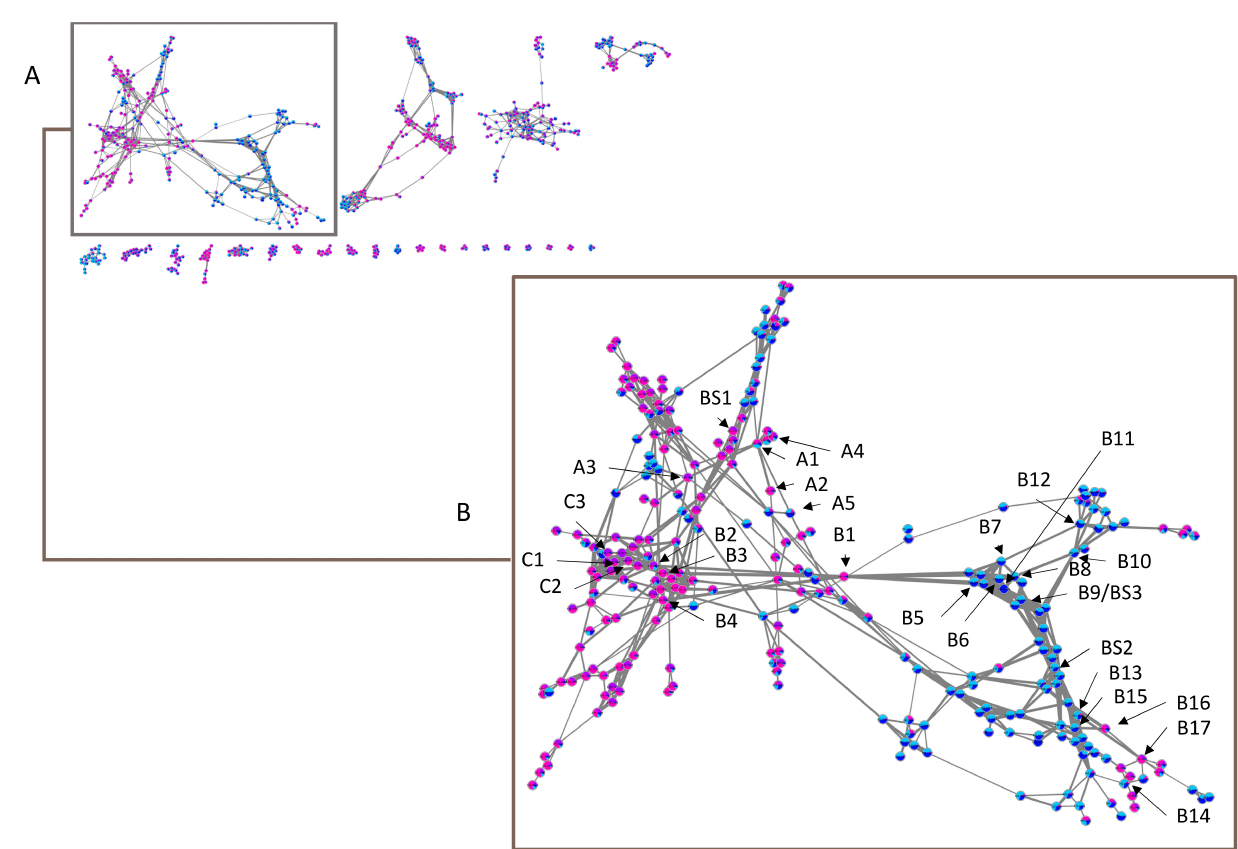
Figure 5. ( A ) Entire molecular network of Erythrophleum samples and ( B ) a zoom on cassane-type diterpene network with indications of annotated nodes. Alphanumeric values A, B and C correspond to subclusters mentioned in Table 2 and BS to annotated features assigned by Biosigner algorithm. Pink in nodes represents proportion of Sua *, violet of Ouesso-Sua, light blue of ivo-Libr1 and dark blue of ivo-Libr2